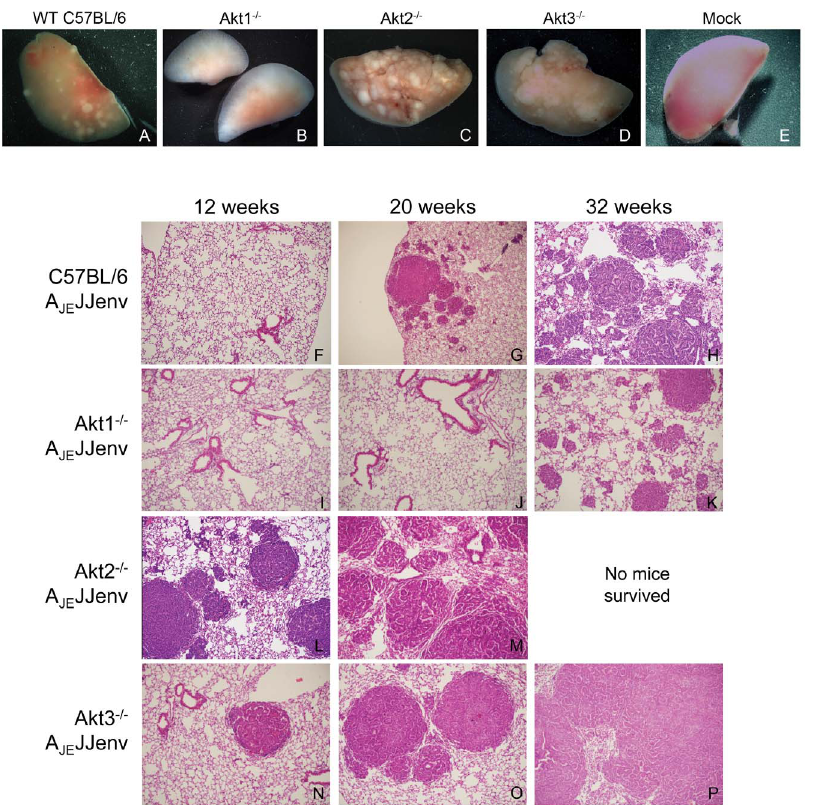
Figure 2. Akt 1 is required for initiation and progression of lung tumors whereas Akt2 appears to be protective against tumorigenesis. Representative macroscopic images of individual lung lobes harvested from A JE JJenv infected WT (A), Akt1 2 / 2 (B), Akt2 2 / 2 (C), and Akt3 2 / 2 (D) mice as well as mock infected mice (E) at 20 weeks post-infection. Representative images of hematoxylin and eosin stained sections from the lungs of WT (F to H), Akt1 2 / 2 (I to K), Akt2 2 / 2 (L and M) and Akt3 2 / 2 (N to P) mice infected with A JE JJenv and harvested at 12, 20 and 32 weeks